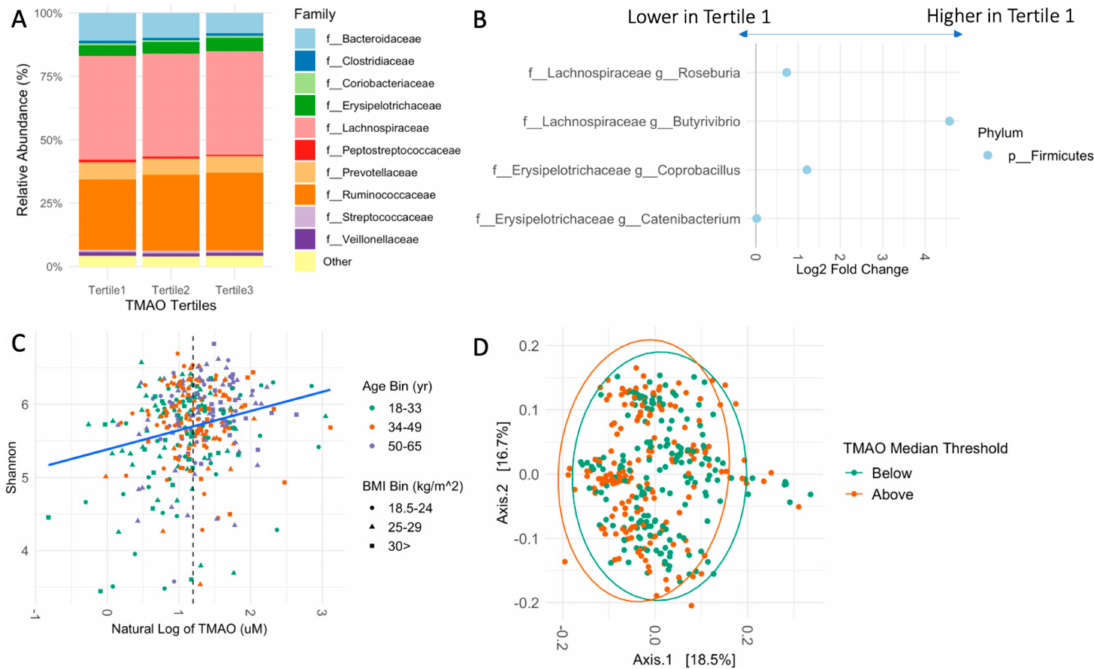
Figure 1. Fecal microbiome relates to fasting plasma TMAO in a generally healthy cohort. ( A ) Relative abundance of the top 10 most abundant families by TMAO tertile. ( B ) Genera that are differentially abundant between the low (TMAO 0.44–2.77 µ M) and high TMAO tertile (TMAO > 3.91 µ M). Graph is relative to the low group such that points to the right of 0 are more abundant in the low tertile. ( C ) Alpha diversity is directly related to fasting plasma TMAO (Shannon diversity, β = 0.17, p < 0.001). Point colors represent age bin and shape represents BMI bin. ( D ) Compositional differences are identified between individuals with TMAO less than and greater than 3.32 µ M (Unweighted UniFrac, p =